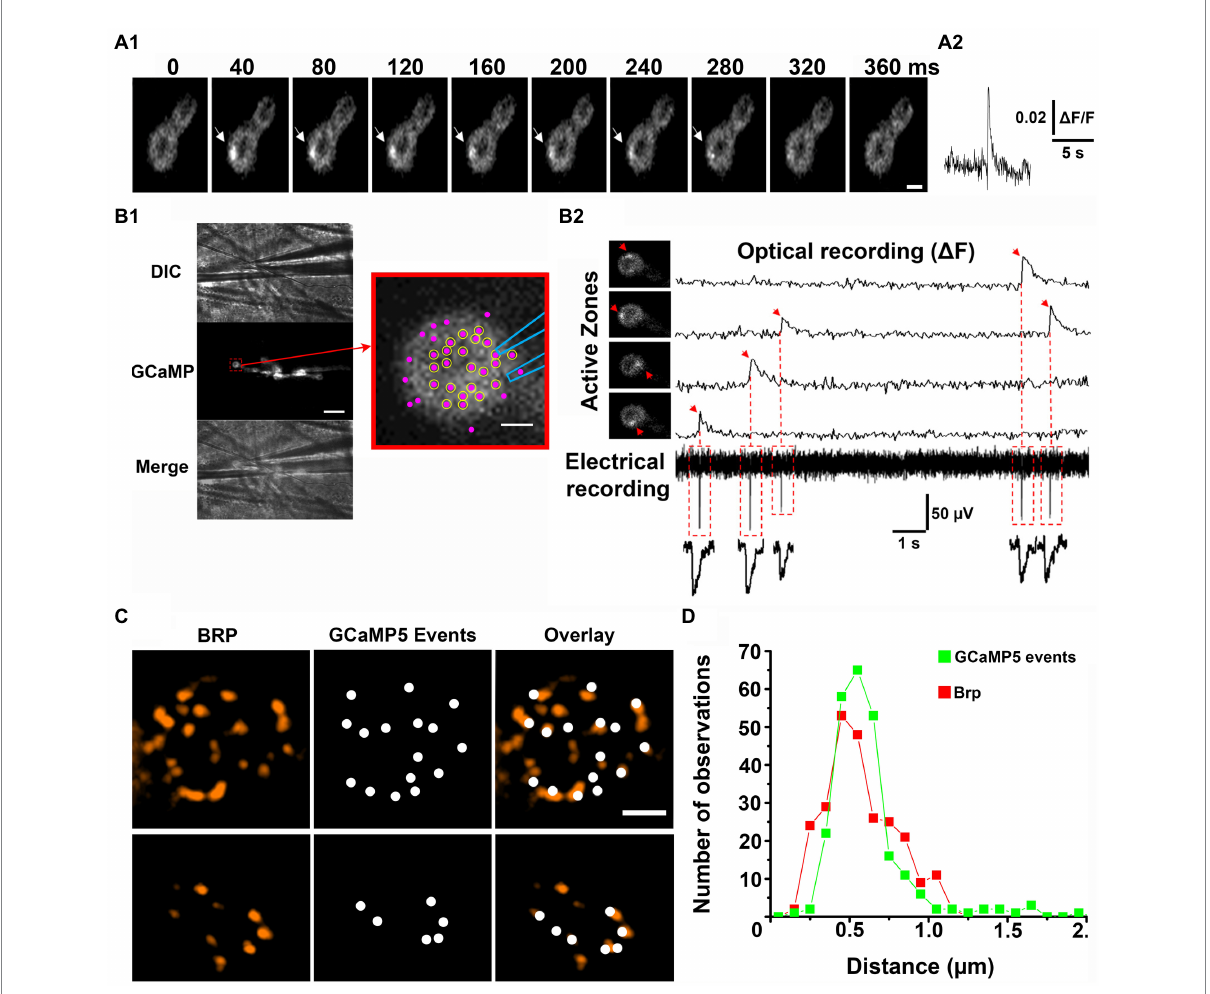
FIGURE 1 Optical detection of release events at individual AZs. Adopted from Astacio et al. (2022). (A) A spontaneous GCaMP5 event. Successive time frames (A1) and the fluorescent profile (A2) . (B) Simultaneous recordings of optical events and postsynaptic currents. (B1) The patch electrode of 1 μ m tip diameter is positioned over the top of the bouton. Scale bar, 10 μ m. The enlarged bouton shows the electrode position and the detected AZs (magenta puncta). Circles represent the AZs in which all the recorded GCaMP events had matching synaptic currents. (B2) Four GCaMP events produced by four different AZs (arrows) recorded simultaneously with electrical activity. The recorded synaptic currents precisely match the onsets of the recorded GCaMP events. (C) The detected GCaMP5 events largely co-localize with Brp puncta (two examples of synaptic boutons are shown). Scale bars: 1 μ m. (D) The distribution of distances between the neighboring release sites defined by GCaMP events (green) versus Brp puncta